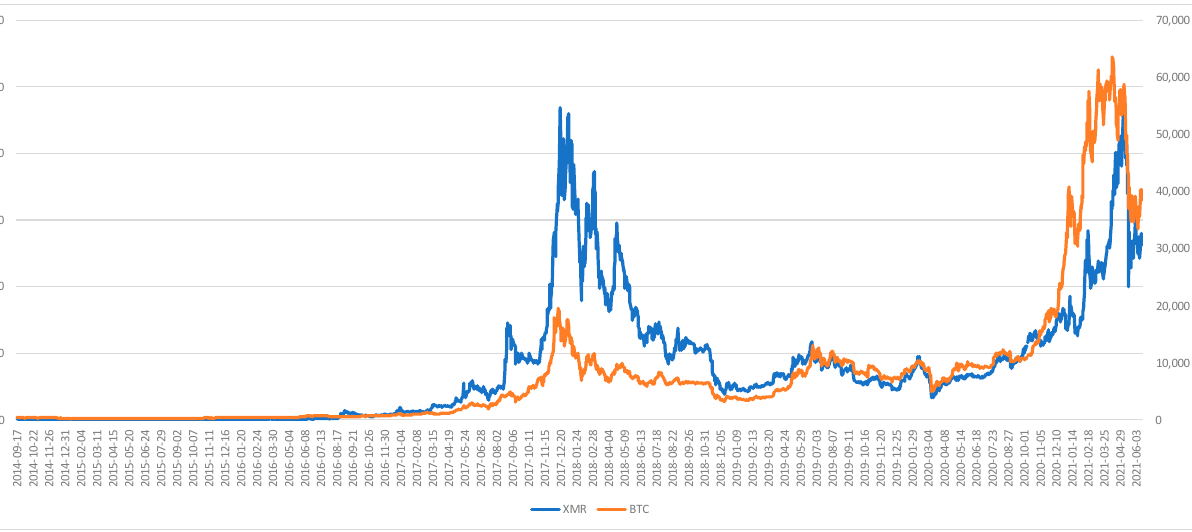
Figure 1. Price development in USD of Bitcoin, BTC (right-side y -axis) and Horizen, ZEN (left-side y -axis).